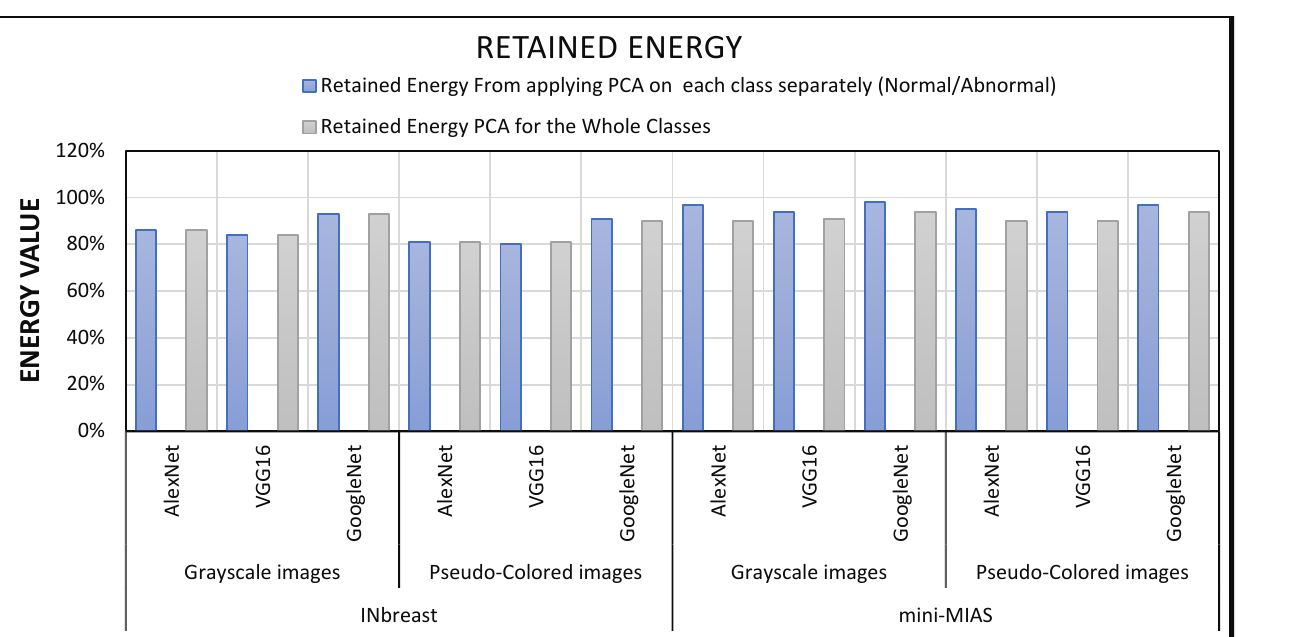
Grayscale images Pseudo-Colored images Grayscale images Pseudo-Colored images INbreast mini-MIAS